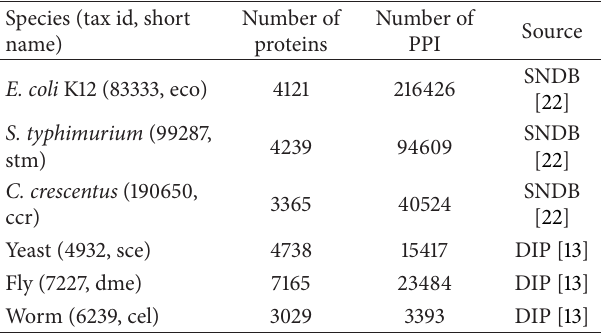
Table 2: The PPI networks analyzed in this paper. Species (tax id,